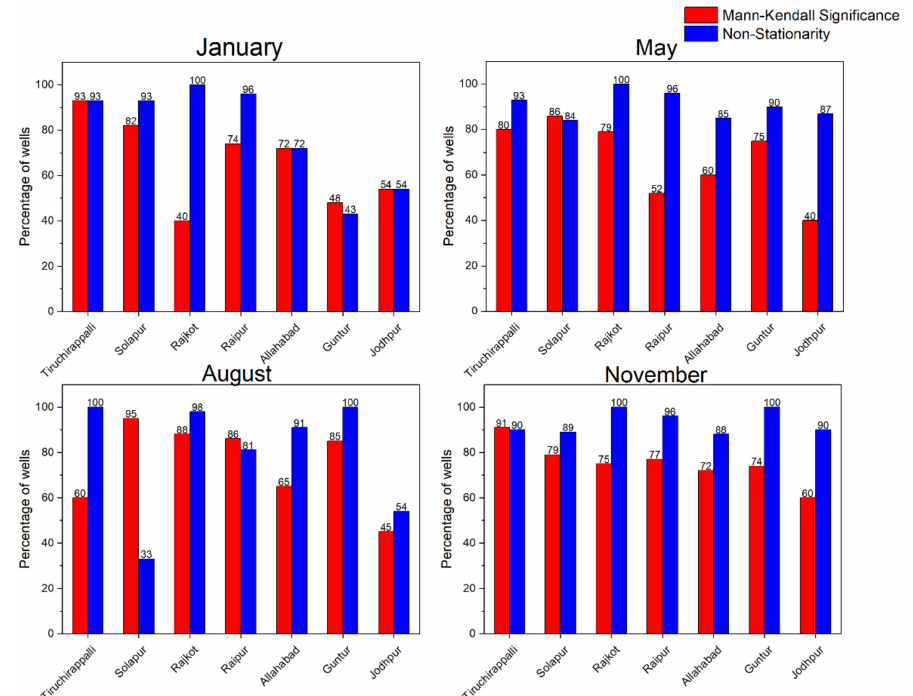
Figure 6. City-wise seasonal split-up of wells with non-stationarity and modified Mann–Kendall (MMK) trend significance in groundwater level